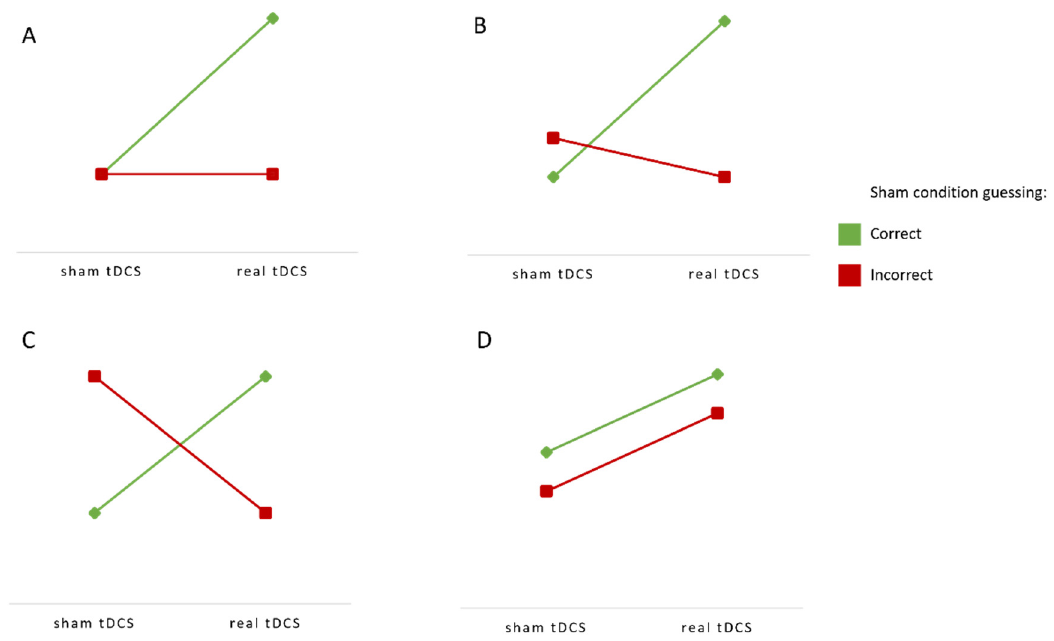
Figure 2. Interpretation of interaction effects between sham condition guessing and the actual tDCS condition. ( A , B ): Significant main effect of stimulation with significant interaction. ( C ): No main effect of stimulation with significant interaction. ( D ): Significant main effect of stimulation with non-significant interaction. ( A – C ) show that a correct sham guess moderates tDCS effects, while ( D ) shows that successful sham-guessing has no impact on the tDCS effects. Finally, the absence of both a stimulation and interaction effect would result in the same cognitive performance across all levels of both variables.